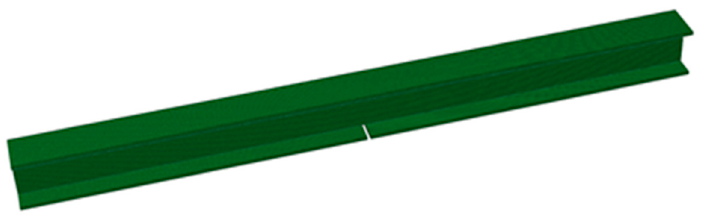
Figure 12. Finite element model of damaged specimen A.